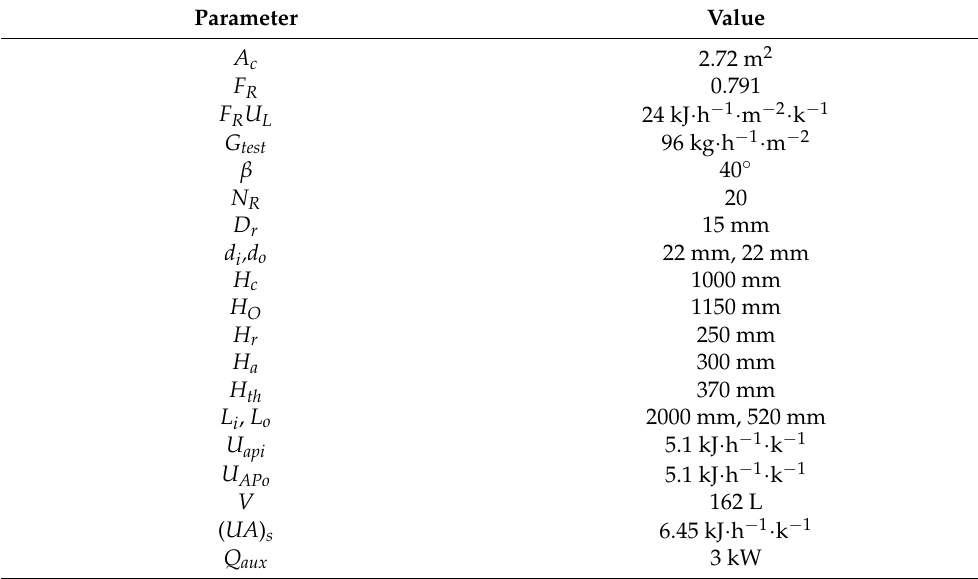
Table 5. Technical parameters of the validation study.